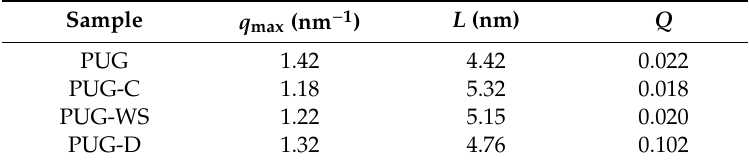
Table 2. Values of the q max (nm − 1 ), L (nm), and Q for the polyurethane composite foams PUG, PUG-C, PUG-WS and